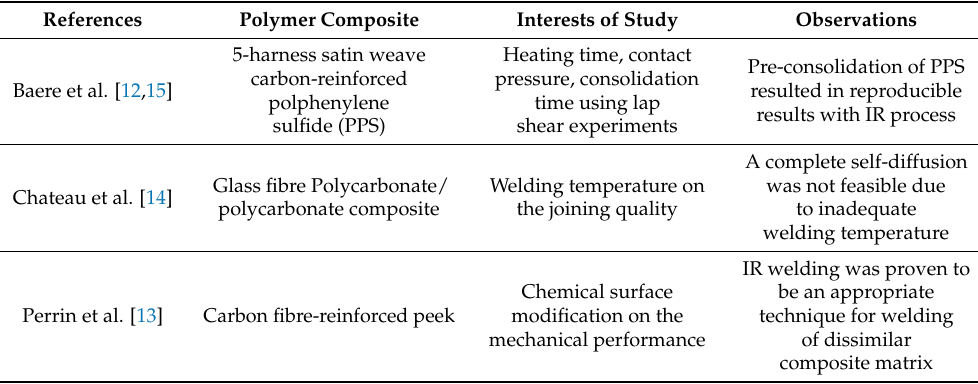
Table 2. Conducted research on IR welding of